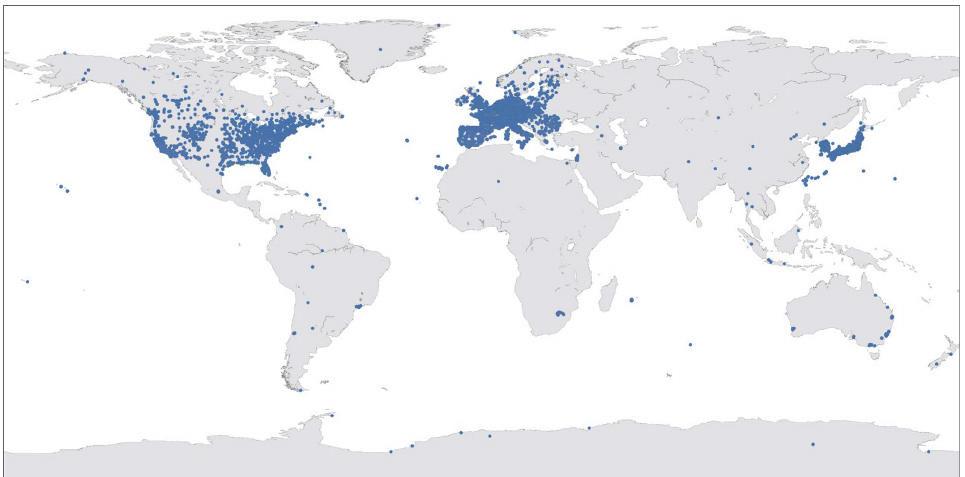
Figure 2. Worldwide measurement stations which are part of AQ-Bench, selected from the TOAR database. Map by Wessel et al.